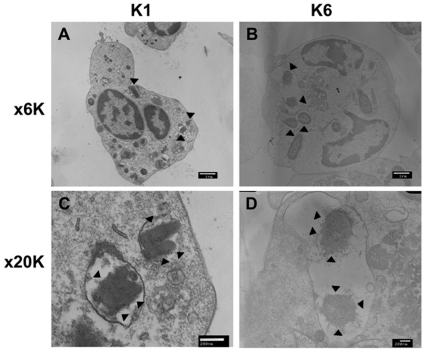
Electron microscopic examination of phagocytosed serotypes K1 and K6 K. pneumoniae.Vacuolated bacteria are evident. The cell wall structure of serotype K1 appears intact, and cell division patterns are visible despite digestion by neutrophils (A & C). In contrast, lysis and the loss of cell wall structure of serotype K6 is seen in the vacuoles of neutrophils (B & D). (Bar = 1 µm, cells magnified ×6K; bar = 200 nm, cells magnified ×20K). Bacteria are pointed by arrow.